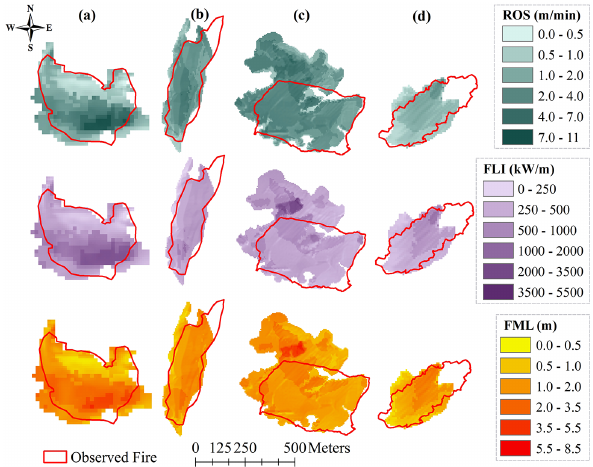
Figure 8. Simulated outputs of rate of spread (ROS), fireline in- tensity (FLI) and flame length (FML) for the most accurate simu- lation (III for Toshi, II for Malekroud, VI for YekeBermagh and I for Gharangi; Table 4): (a) Toshi, (b) Malekroud, (c) YekeBermagh, (d) Gharangi (see Table 4).